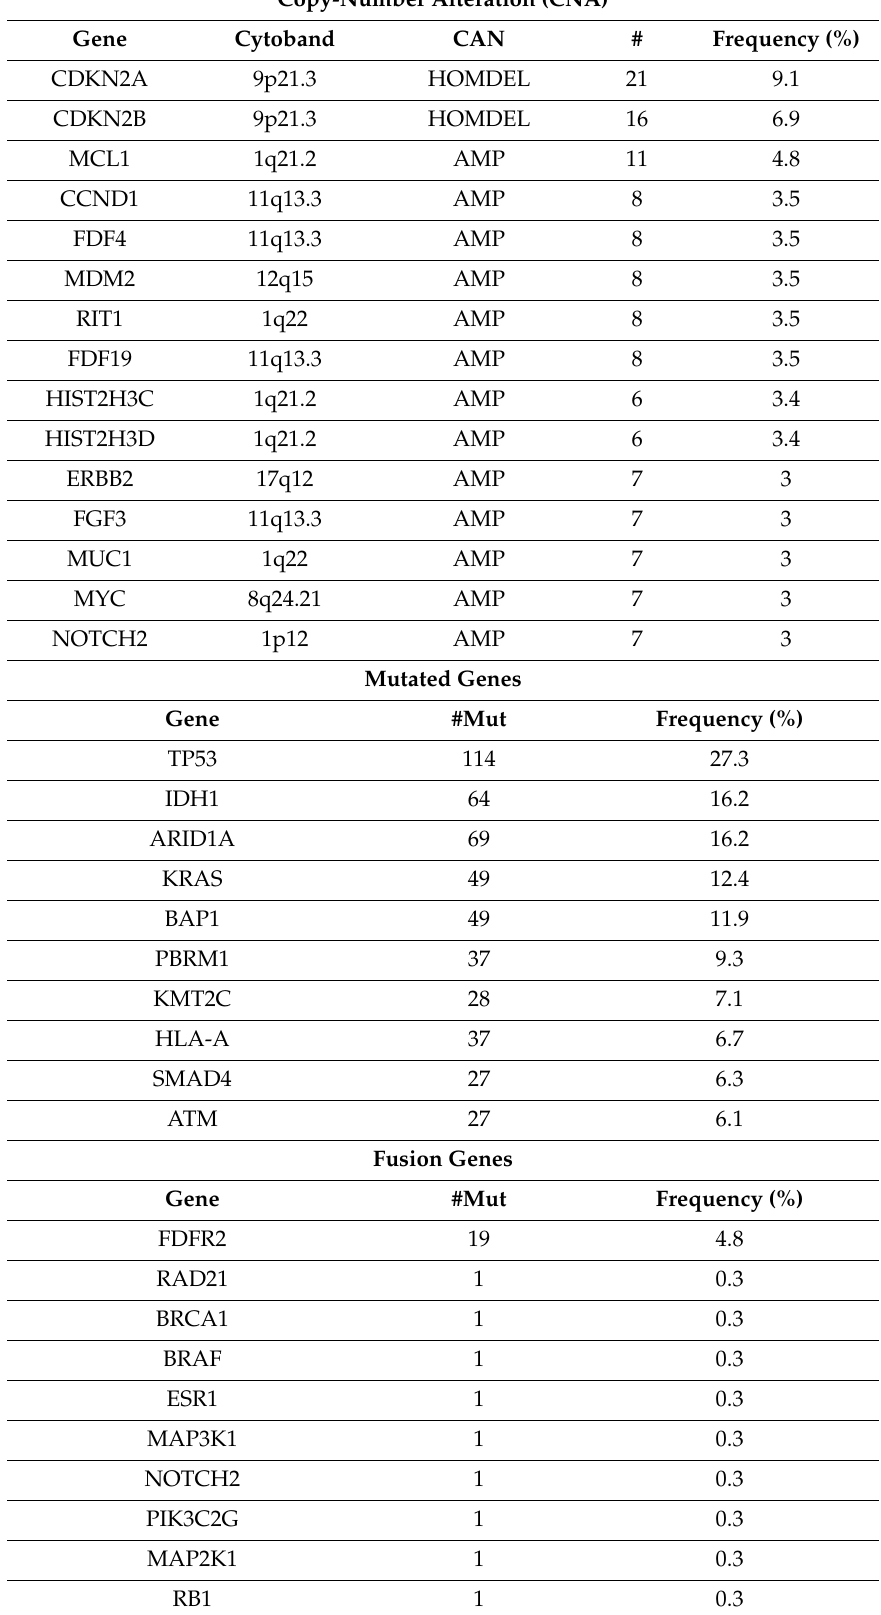
Table 1. Genetic events of cholangiocarcinoma